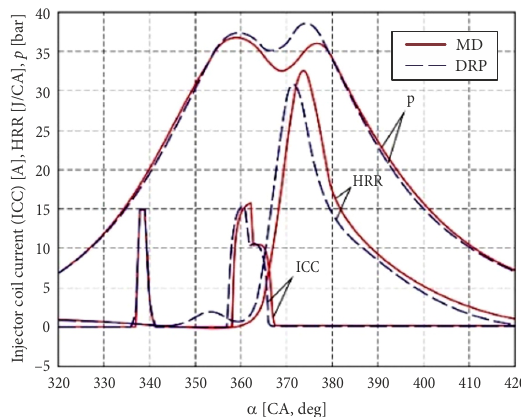
Figure 10. Injection current vs CA for MD and DRP